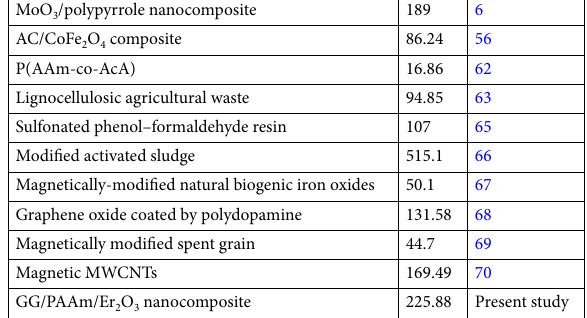
MoO 3 /polypyrrole nanocomposite